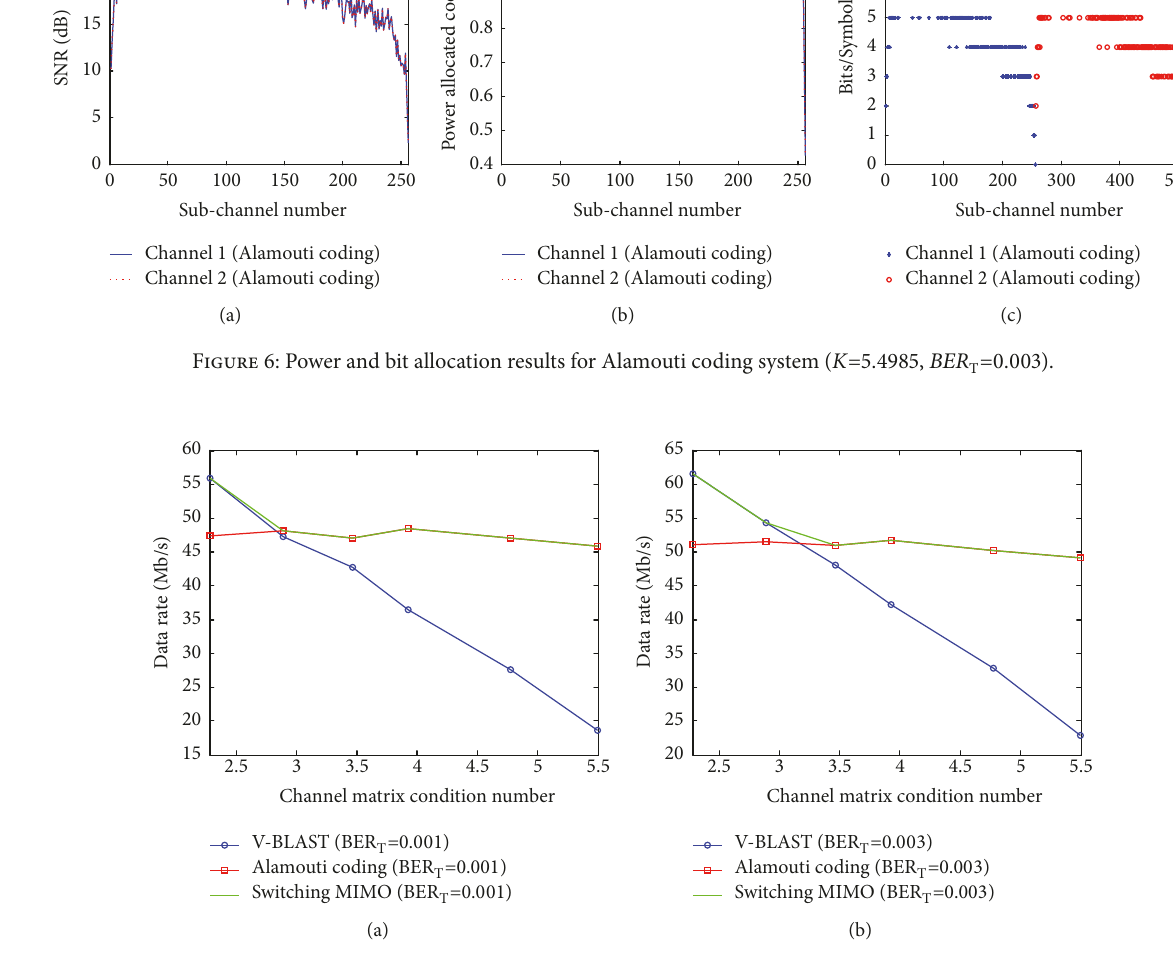
Figure 7: Data rate versus channel matrix condition number: (a) 𝐵𝐸𝑅 T =0.001; (b) 𝐵𝐸𝑅 T =0.003.